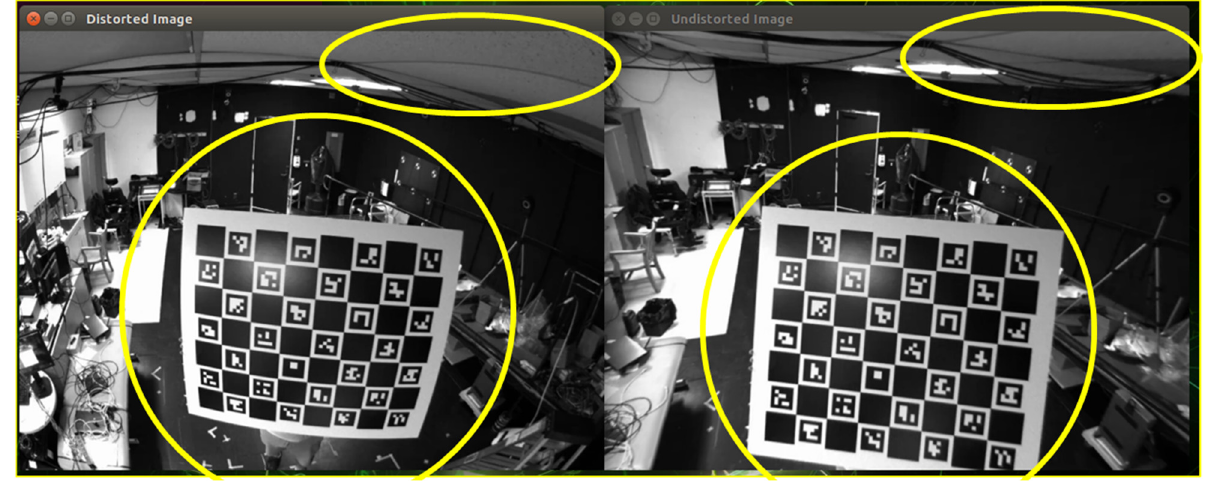
Figure A8. Barrel-distortion removal by camera-distortion model.